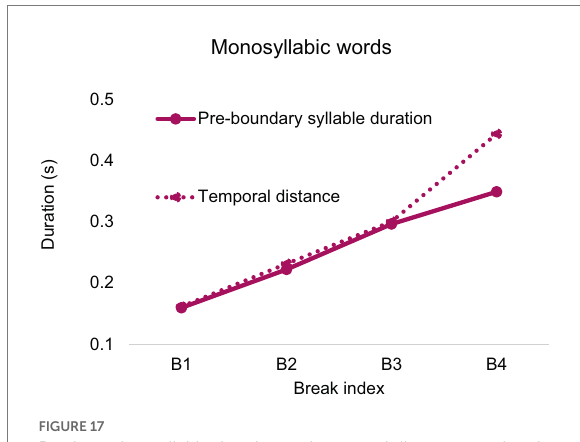
FIGURE 17 Pre-boundary syllable duration and temporal distance over break index after monosyllabic words in English.